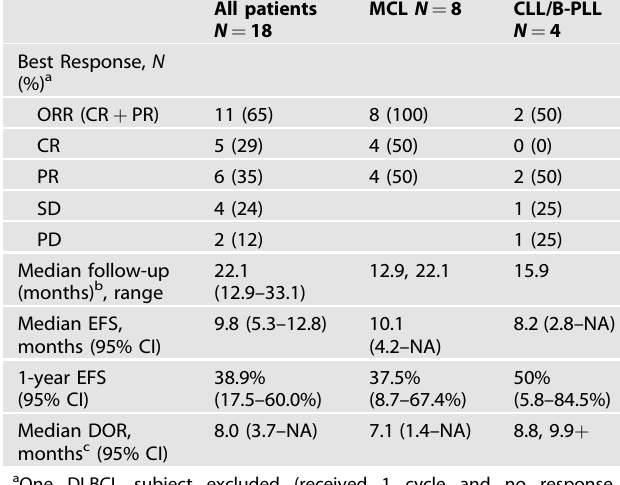
Table 3. Ef fi cacy data.